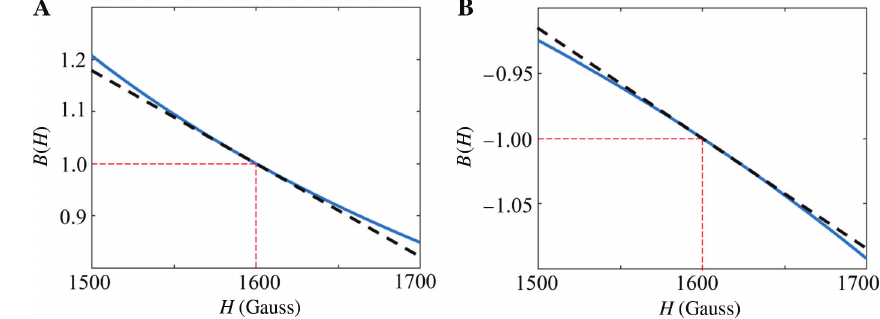
Figure 2: Relations of B ( H )- H at different frequencies. Relation of B ( H ) with H at: (A) f